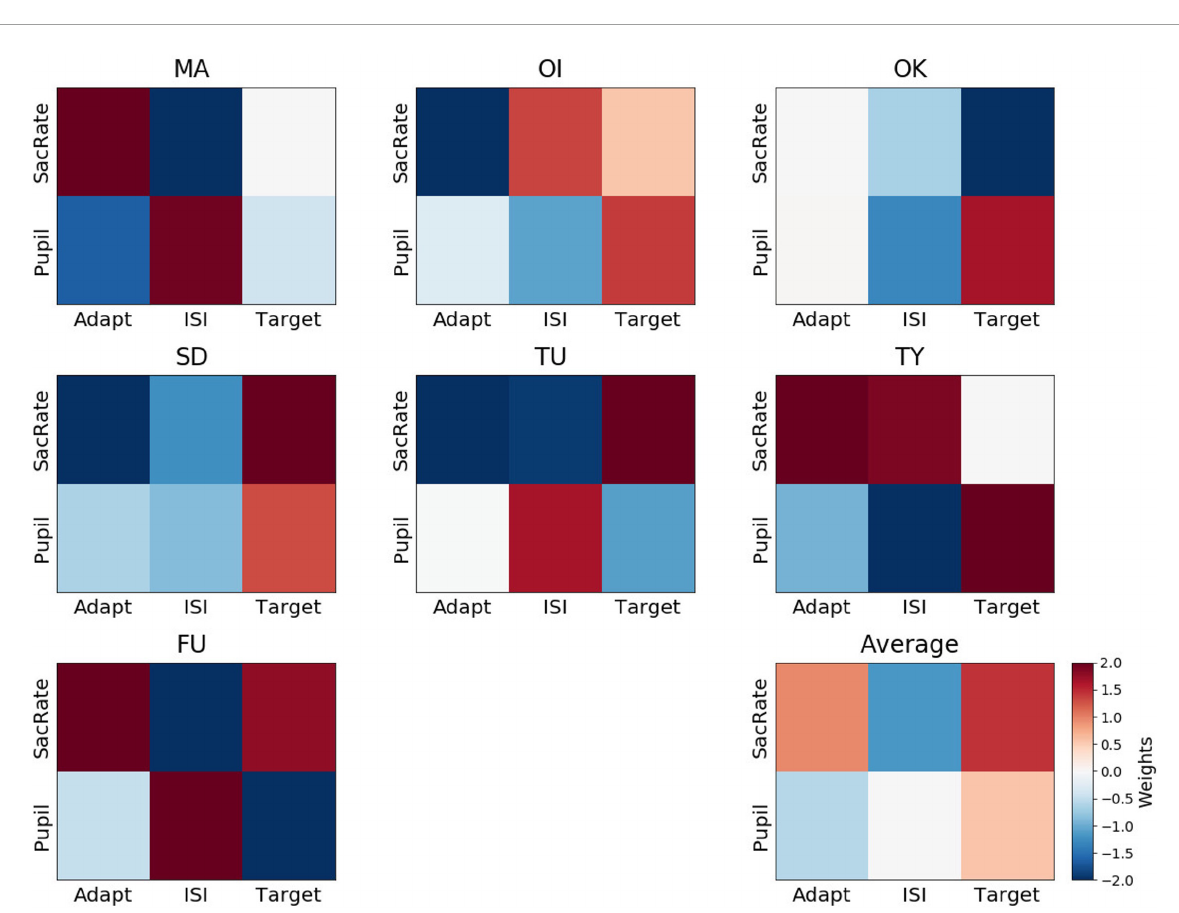
the participants. This decoder was not better than the chance level (accuracy = 0.56, p = 0.98, AUC = 0.50, p = 0.68)